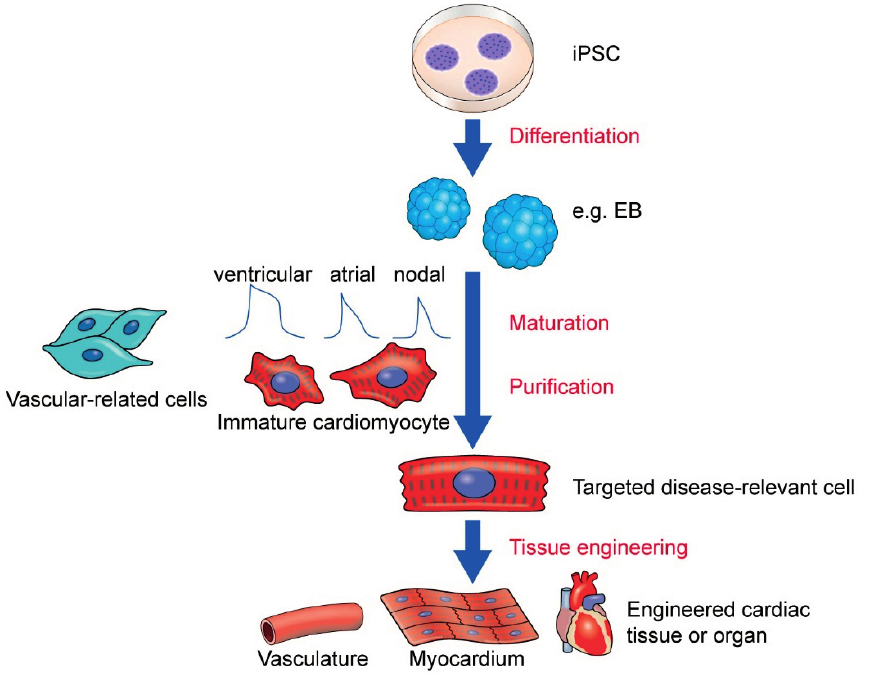
Figure 2. Steps toward clinical application and disease modeling using iPSCs. iPSCs can be differentiated into cells from all three germ layers via several methods, including via